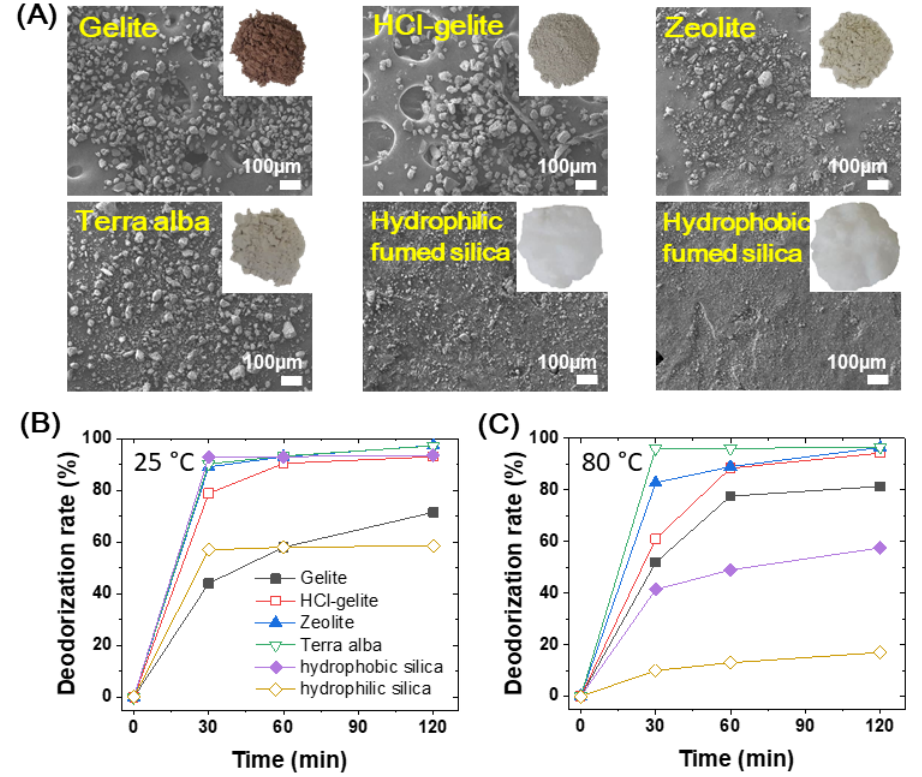
Figure 3. Deodorants and deodorization characteristics. ( A ) SEM images of original deodorants. Inset: photo images of original deodorant powders. ( B , C ) Ammonia deodorization rate of the original deodorants depending on the deodorization time at 25 ◦ C ( B ) and 80 ◦ C ( C